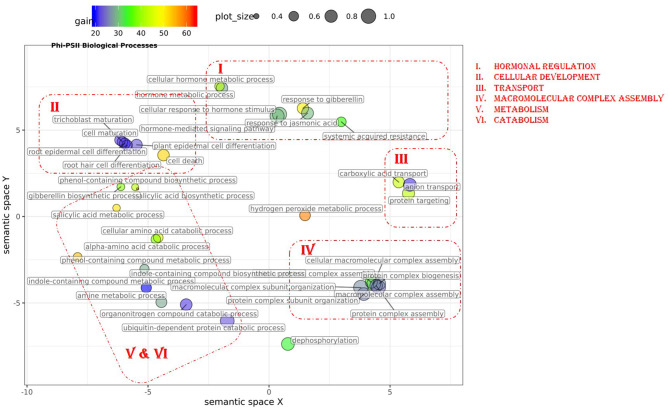
Semantic clustering of GO informed prediction for ΦPSII. Multidimensional scaling (MDS) plot of the representative subset (i.e., terms remaining after the redundancy reduction) of biological process GO terms informative for ΦPSII. Semantically similar GO terms are clustered based on the “SimRel” semantic similarity measure using Revigo. Dot size is proportional to the number of genes annotated with the GO term, such that more general GO terms have larger circles. The x and y coordinates indicate relative cluster distances in 2 dimensions. The %gain of a particular GO term is indicated by the circle color.